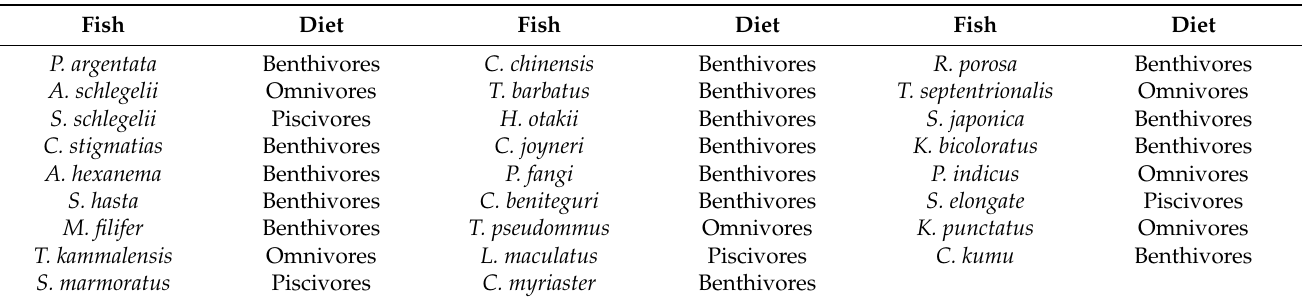
Table 1. Function feeding group of fish consumers.